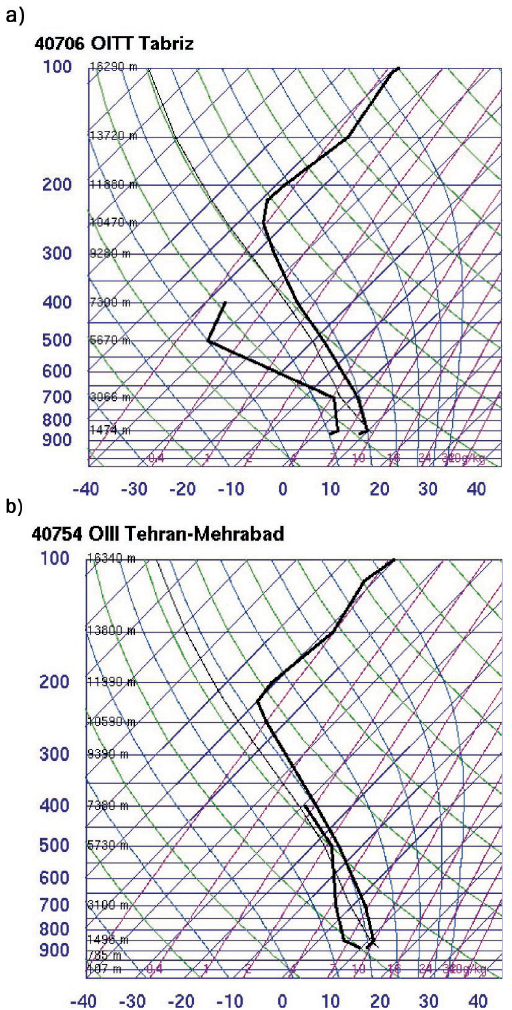
Fig. 8. (a) Thermodynamic diagrams on 30 April 2009 for Tabriz station at 00:00UTC. (b) Thermodynamic diagrams on 30 April 2009 for Tehran at 12:00UTC.